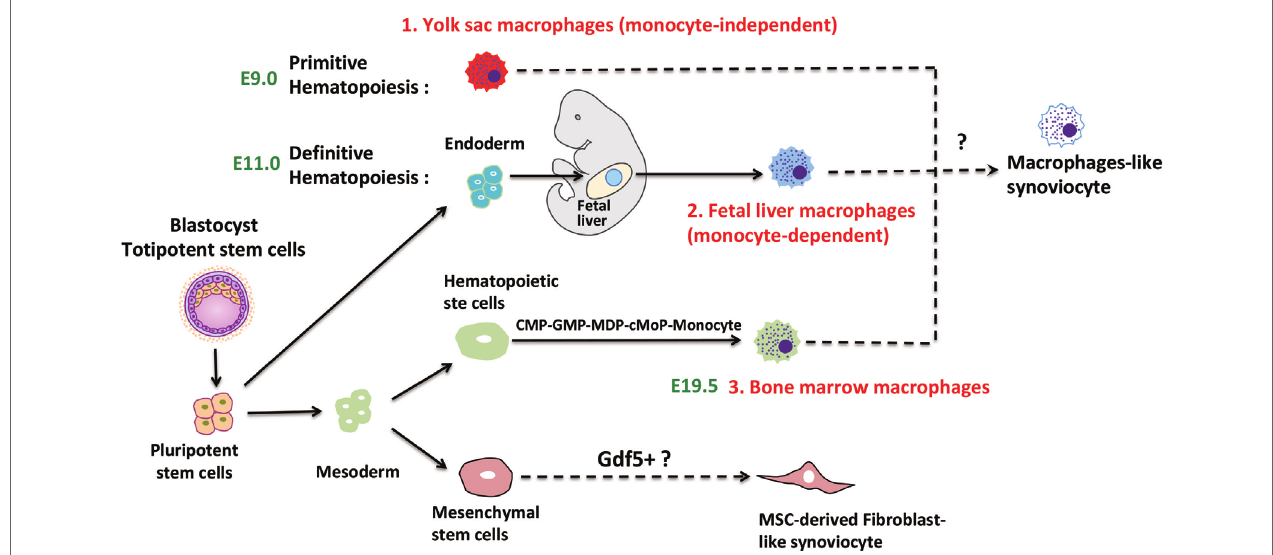
FiGuRe 1 | Speculative ontogeny of fibroblast-like synoviocytes (FLS) and macrophage-like synoviocytes (MLS). Macrophages from different organs/tissues are derived from embryonic stem cells (primitive and definitive hematopoiesis) or circulating monocytes (22). During murine embryogenesis, primitive hematopoiesis is firstly detected in blood islands of the yolk sac at around E7.5, which followed by definitive hematopoiesis in aorta-gonad-mesonephros (AGM) regions, then shifts to the fetal liver, spleen, and bone marrow. MLS most certainly are derived from embryonic precursor cells but the detailed ontogeny is still elusive. FLS may originate from Gdf5 + mesenchymal cells (E7.5, Day 7.5 at embryonic stage; E9.0, Day 9 at embryonic stage; E11.0, Day 11 at embryonic stage; E19.5, Day 19.5 at embryonic stage).